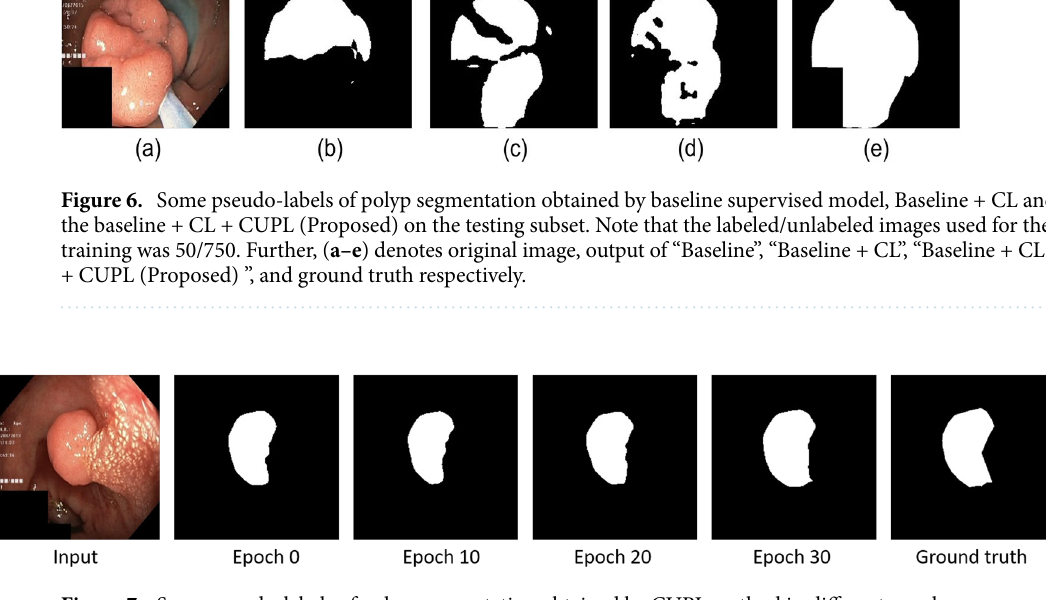
Figure 7. Some pseudo-labels of polyp segmentation obtained by CUPL method in different